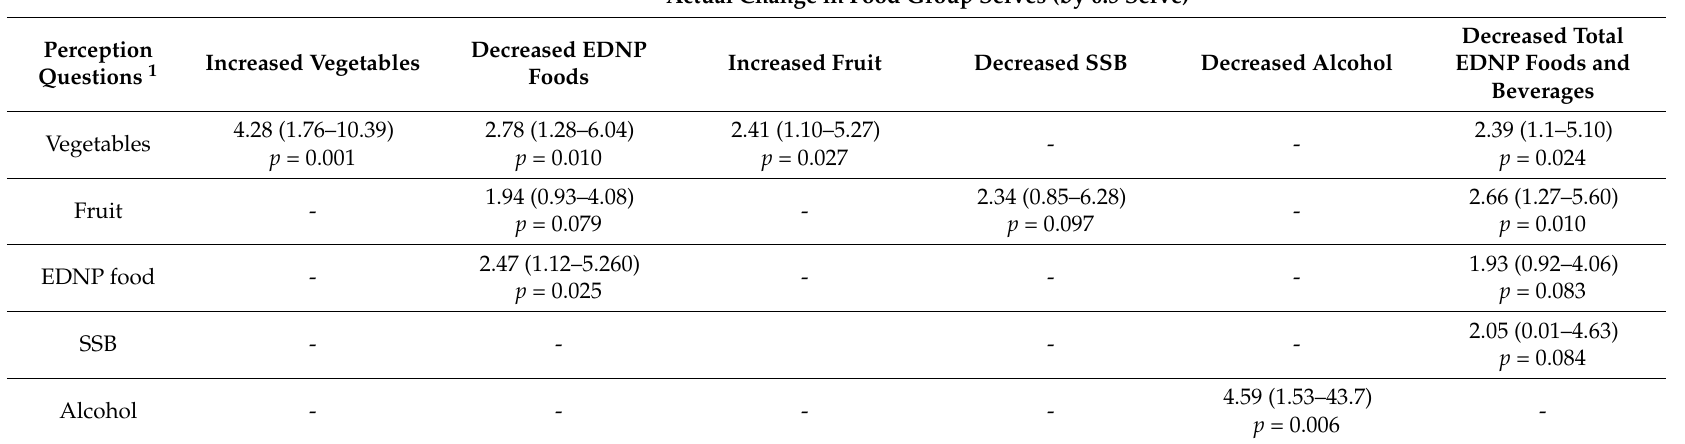
Table 3. Logistic regression analyses adjusted for age and sex relating participants’ positive perception on text message dietary feedback to the actual change in food group serves (by 0.5 serves). Effects are represented as odds-ratio and associated 95% confidence intervals. Odds-ratio represents the increase in the likelihood of participants who agreed compared to those who disagreed, that the text messages made them think about how much they ate and their actual